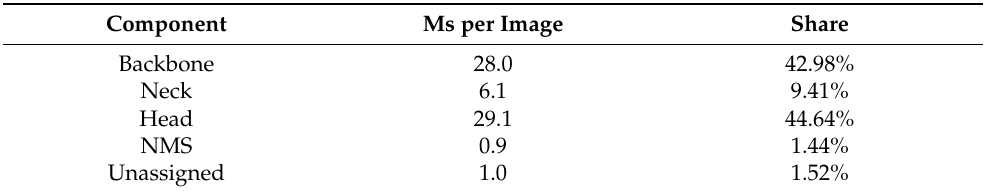
Table 10. Runtimes of RetinaNet’s components. Due to technical reasons some operations could not be assigned to a certain component. The backbone and the head are the two significant parts sharing almost 90% of the runtime equally. The remaining share is mainly consumed by the